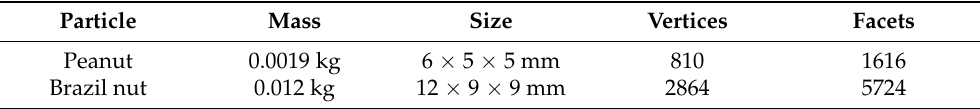
Table 2. Parameters in the Brazil nut effect simulation.